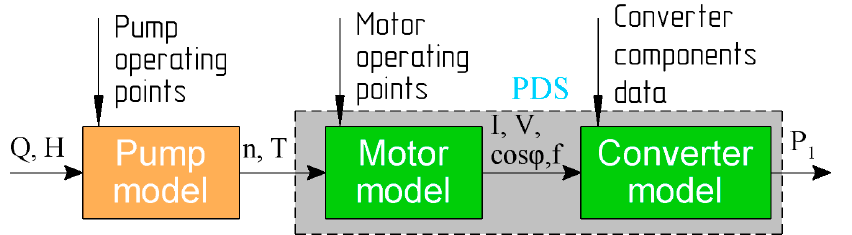
Figure 1. General structure of the whole drive system.